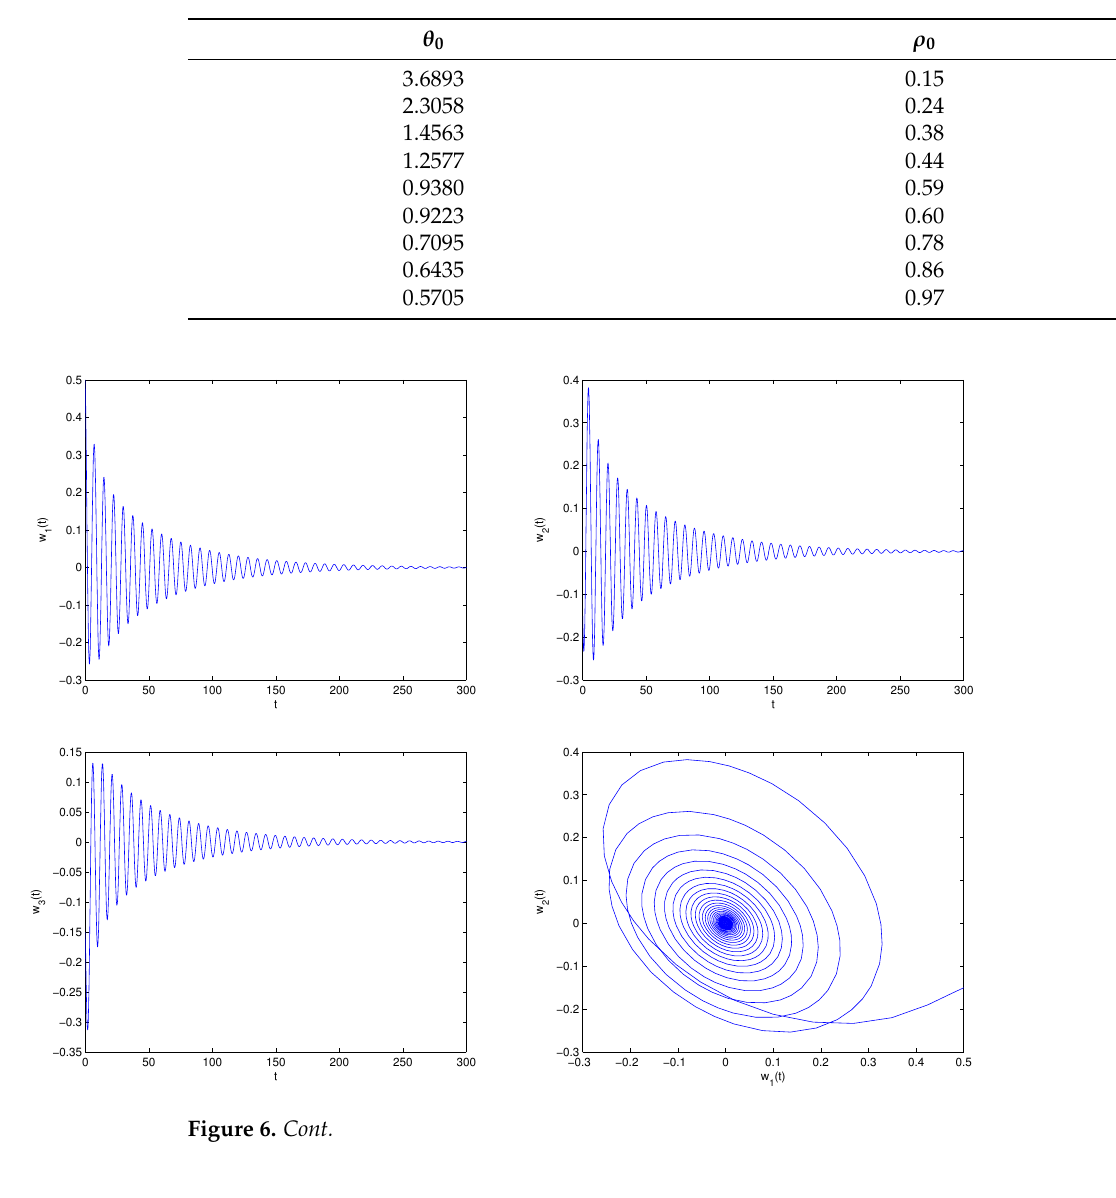
Figure 5. Bifurcation figure of system (95): ρ versus w 3 . The bifurcation value ρ 0 ≈ 0.6. Table 1. The relation of θ 0 and ρ 0 of system (95).